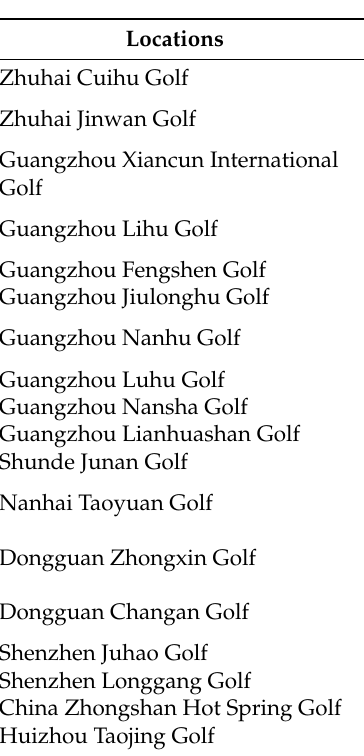
Table 1. Sampling locations and turf